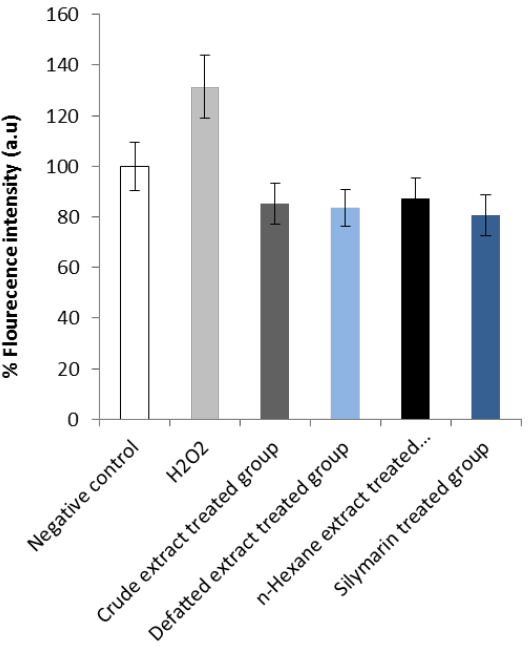
Figure 2. Reactive oxygen species (ROS) induction by H 2 O 2 in the Hep G2 human liver cancer cell line: scavenging effects of various Premna odorata extracts. The cells were treated with 100 µL and evaluated for ROS production as described in the Materials and Methods. The data (means ± SD) are representative of three independent experiments. Significant difference at p ˂ 0.05 versus H 2 O 2 .